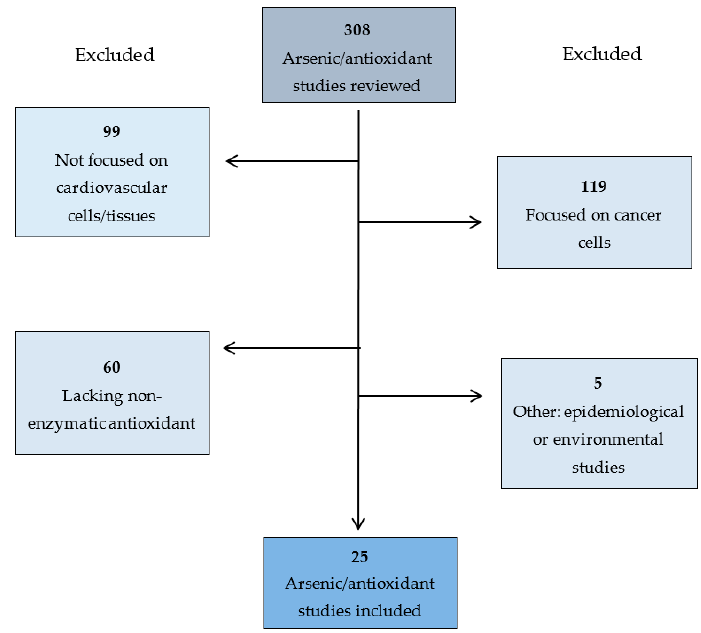
Figure 1. Schematic of selected references.